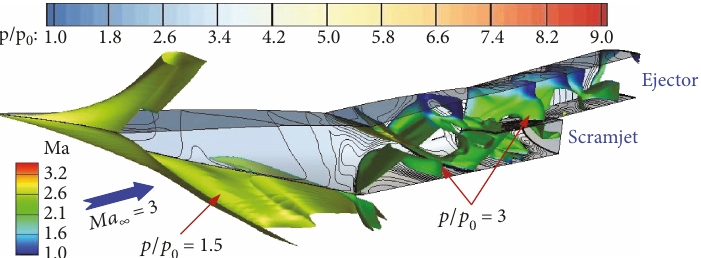
= 3 . The surface wall is contoured by the pressure ratio p/p ∞